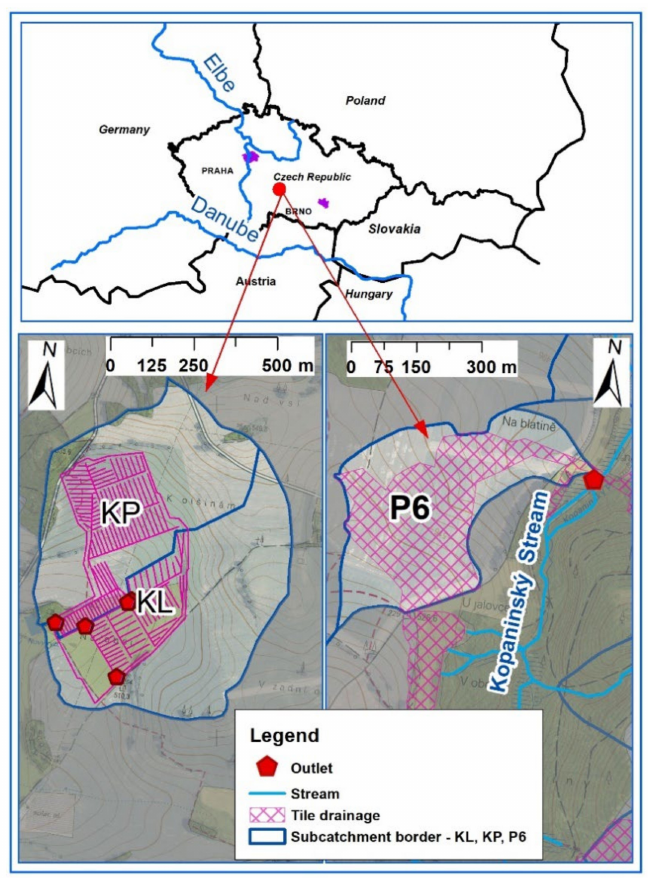
Figure 1. Map of study